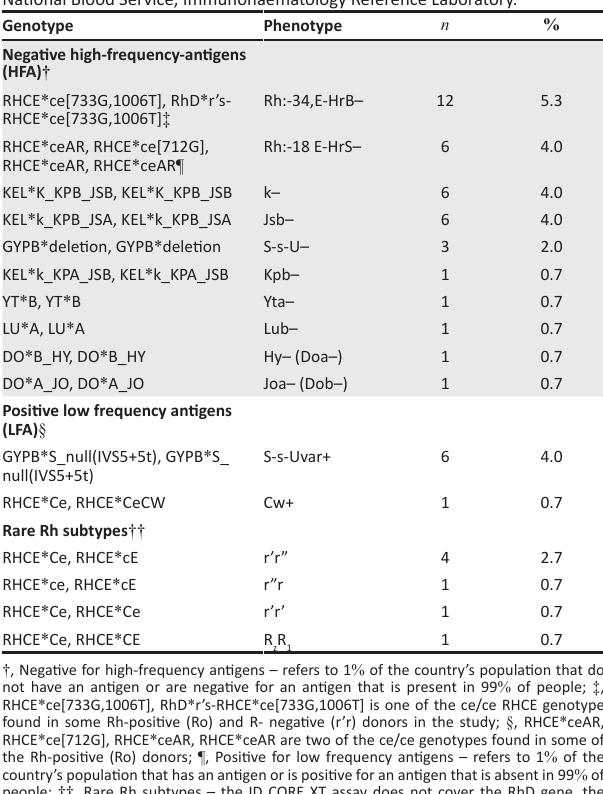
expand screening for this rare antigen in South Africa to all TABLE 2: Rare blood types by antigen type and frequency found among 150